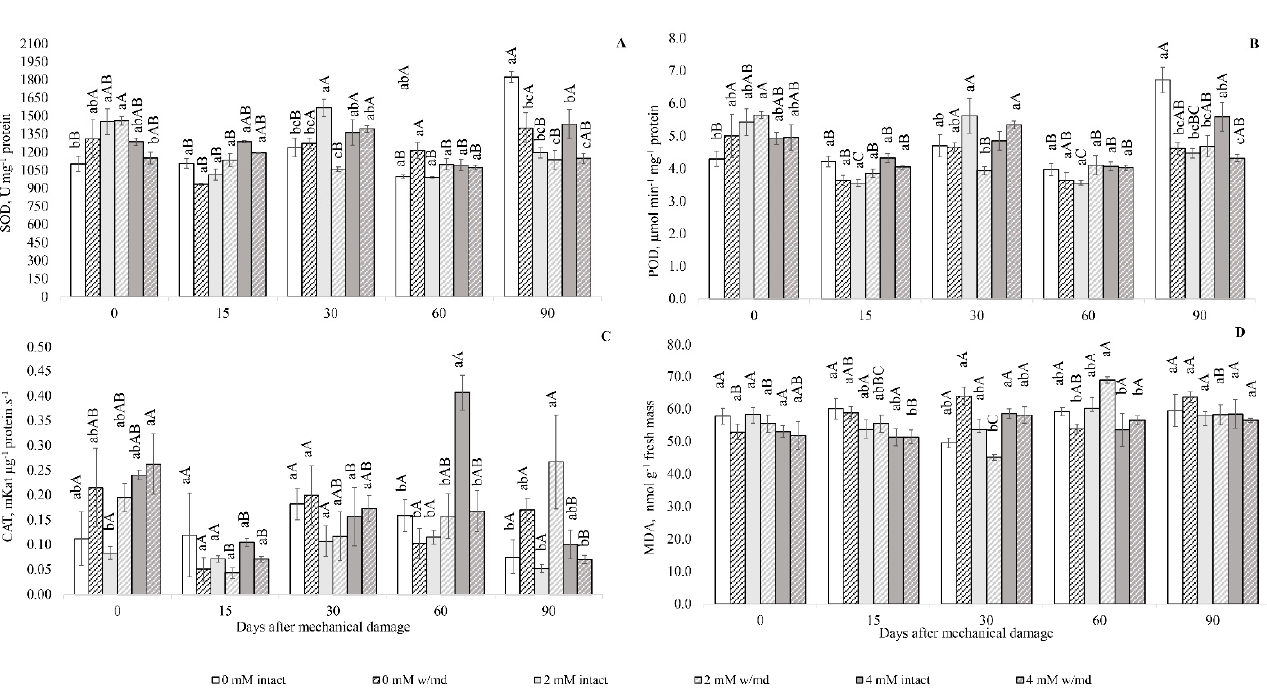
Figure 9. Antioxidant enzyme activity ( A ) Superoxide dismutase (SOD) p < 0.001; ( B ) Catalase (CAT) p < 0.001; ( C ) Peroxidase (POD) p < 0.001; ( D ) Lipid peroxidation expressed by the formation of malonaldehyde (MDA) p < 0.001 in Annona emarginata plants submitted to the treatments: 0 mM Ca 2+ without mechanical damage (intact), 0 mM Ca 2+ with mechanical damage (w/MD), 2 mM Ca 2+ intact, 2 mM Ca 2+ w/MD, 4 mM Ca 2+ intact, and 4 mM Ca 2+ w/MD, at times: 0 (30 min) 15, 30, 60, and 90 days. Values correspond to means ± SE ( n = 4). Lowercase letters indicate differences between treatments within each evaluation time and uppercase indicate differences between each treatment over evaluation time.